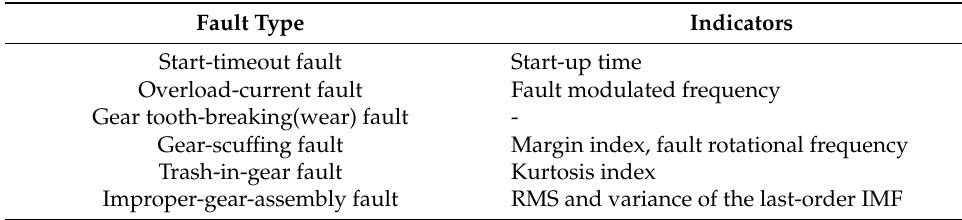
Table 3. Summary of